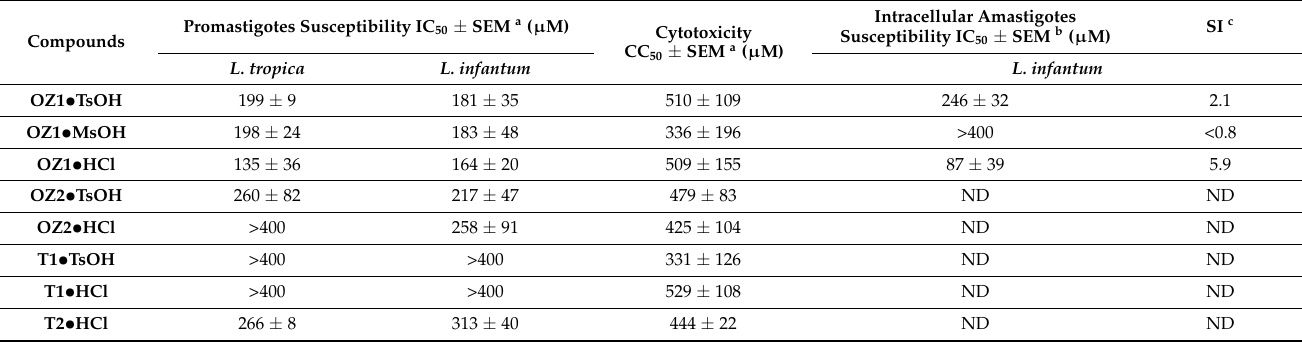
Table 5. Cytotoxic concentrations (CC 50 ) in THP-1 cell line, inhibitory concentrations (IC 50 ) in promastigote forms of L. infantum and L. tropica , and in intracellular amastigote forms of L. infantum and selective index (SI) of synthetic endoperoxide–pyrazole